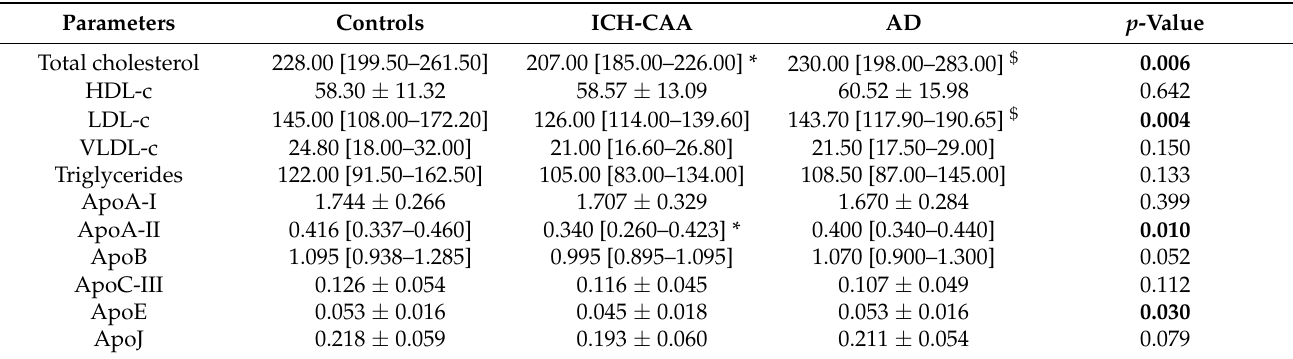
Table 2. Lipid profile and apolipoprotein concentration in plasma.